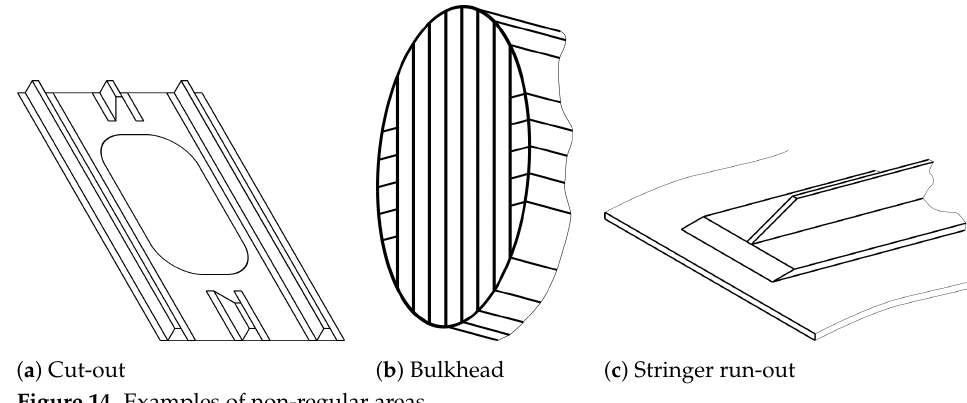
Figure 14. Examples of non-regular